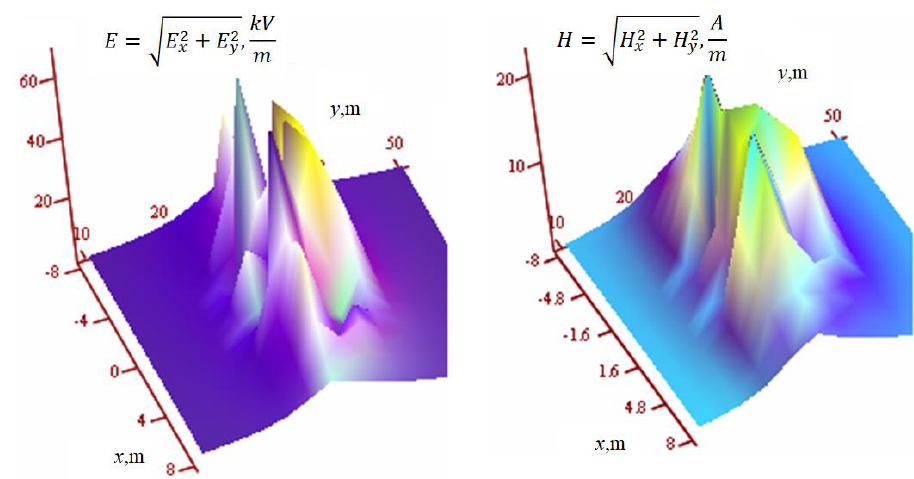
Figure 14. Spatial structure of the EMF strengths of a three-segment compact overhead line.